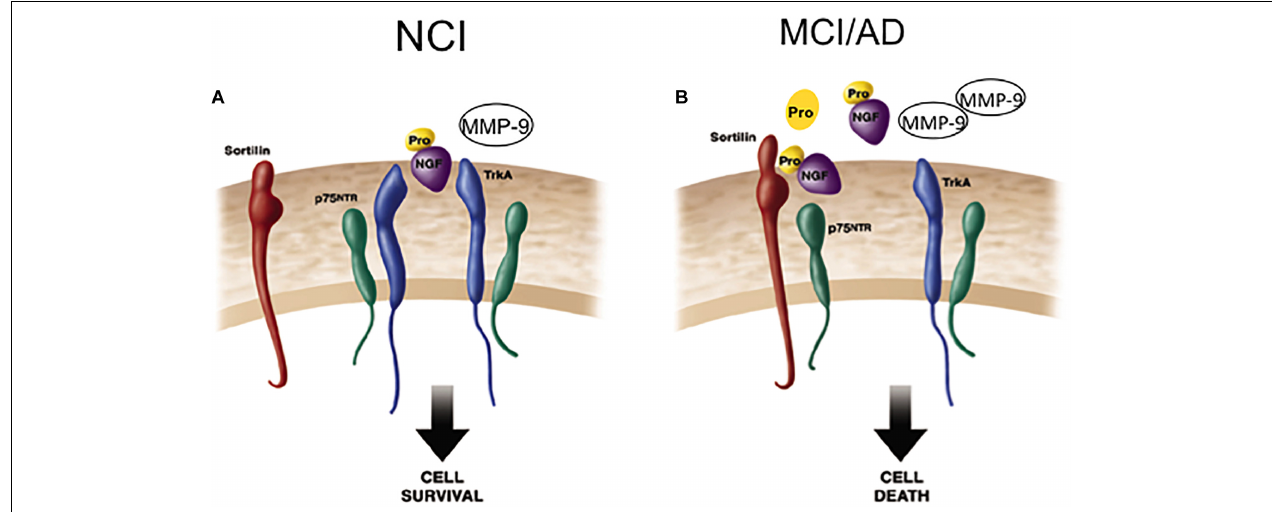
FIGURE 6 | Cartoon demonstrating the shift from cell survival to cell death related to NGF activity during the progression of AD. (A) ProNGF/TrkA complex activates cell survival mechanisms, which is facilitated by the co-expression of p75 NTR on the cell surface in the healthily aged brain. ProNGF also creates a signaling complex by simultaneously binding to sortilin a co-receptor for proNGF. (B) In AD, elevated cortical proNGF in the face of reduced TrkA enhances binding of proNGF to p75 NTR /sortilin complex. Since sortilin acts as a molecular switch governing a p75 NTR mediated pro-apoptotic signal, increased proNGF triggers cell death in the face of decreased TrkA. Modified from Mufson et al.